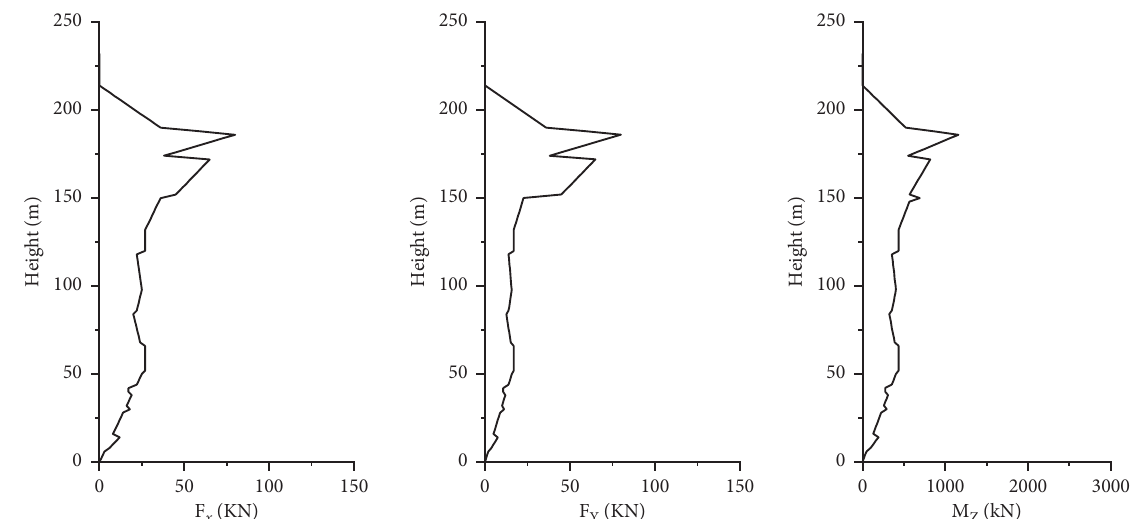
Figure 10: Equivalent static wind loads (corresponding to RMS of displacement, 90 ° wind direction, 100 years return period).